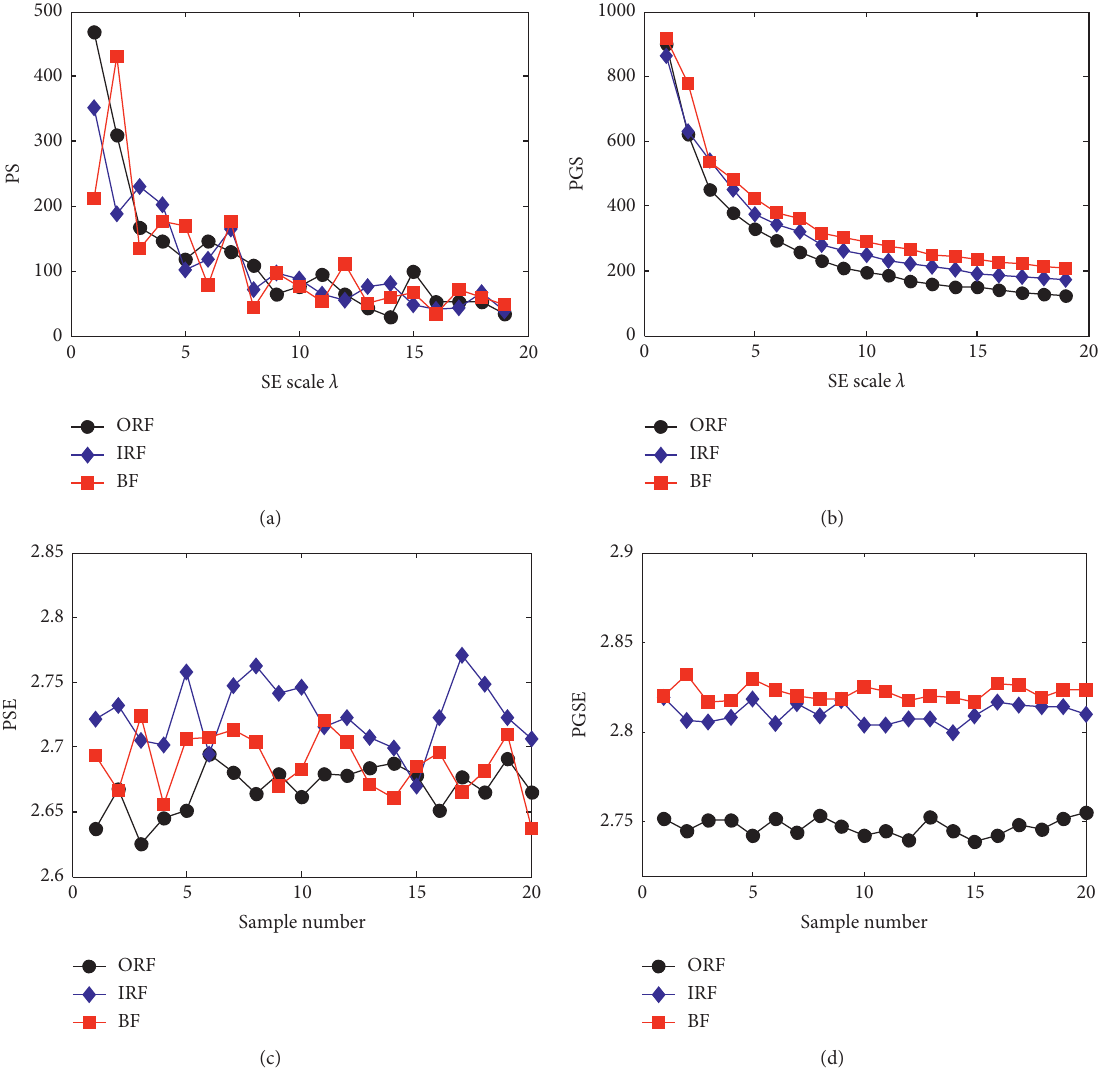
Figure 2: The analysis results of different simulation signals under white noise: (a) PS, (b) PGS, (c) PSE, and (d)